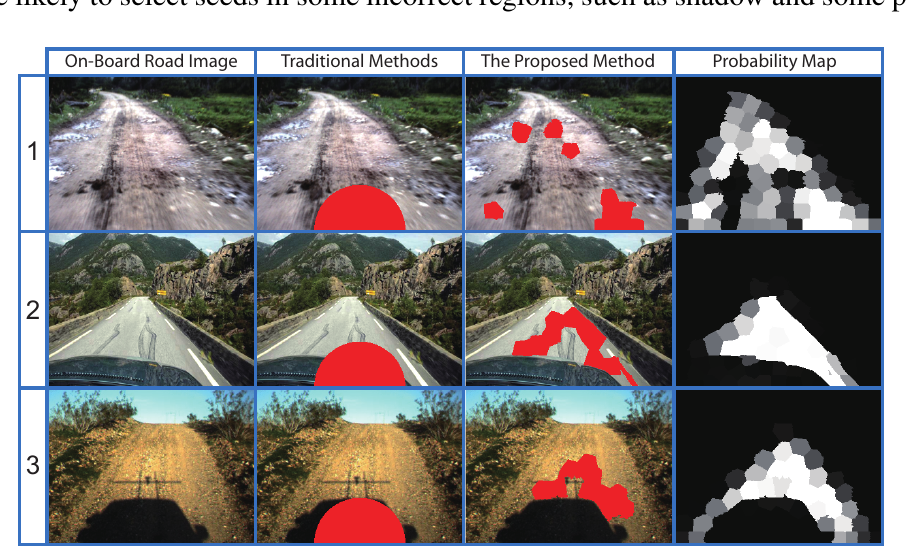
Figure 9. Comparisons with the traditional seed selection